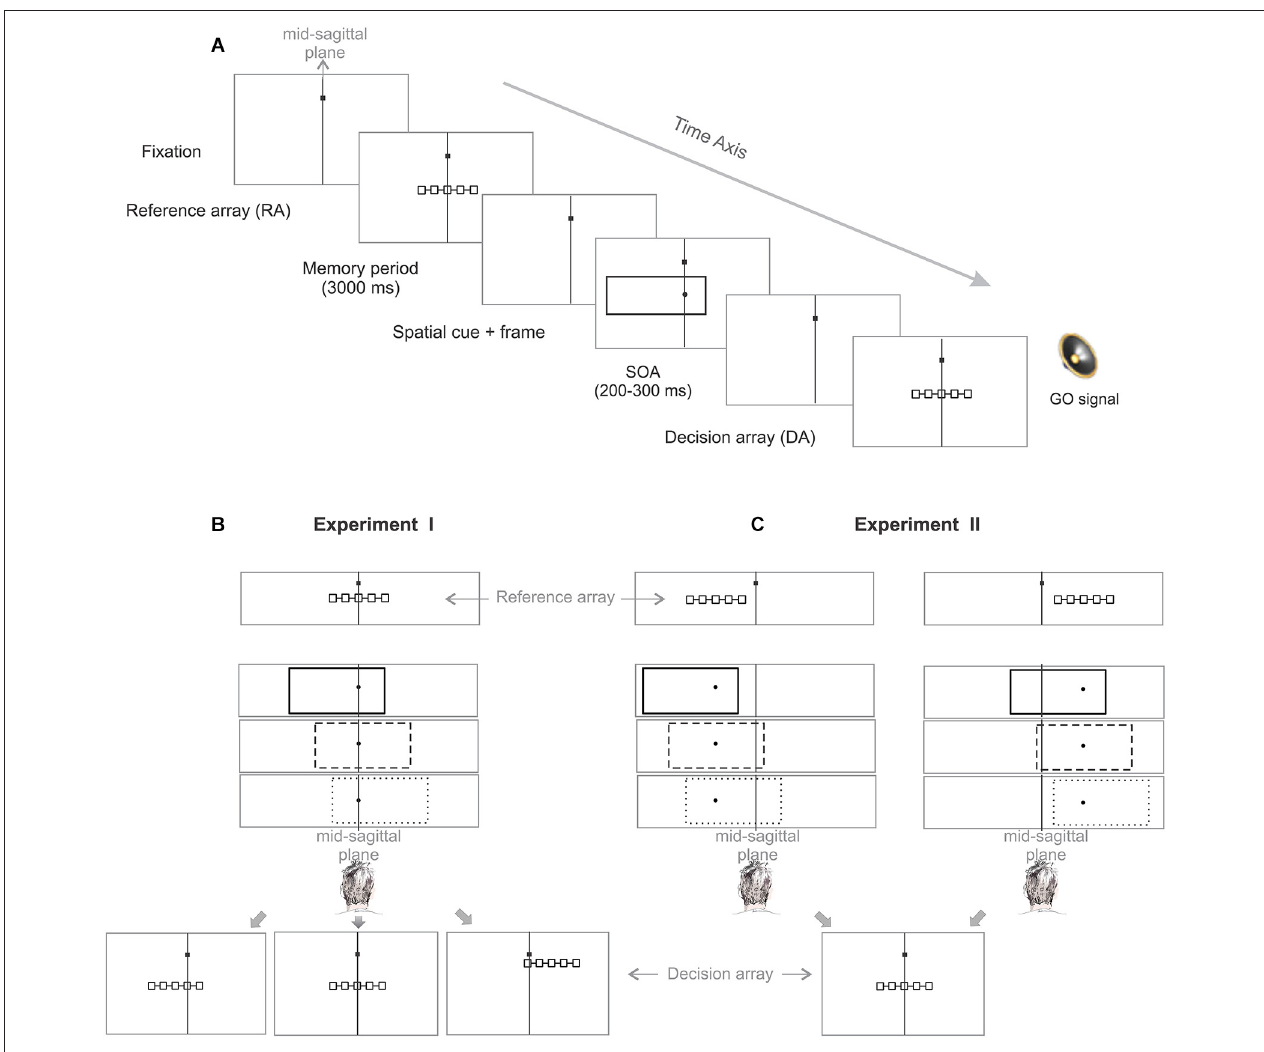
frame, we disentangled the position of the RA and DA for two-thirds of the trials. The congruency of the RA-DA was unpredictable to subjects in each trial. Therefore, to perform the task correctly, subjects had to encode the cue relative to the RA, i.e., use object-based (allocentric) spatial encoding. (C) Experiment II: In order to directly test the biased-midline hypothesis we disentangled the position of the RA from subject’s objective straight-ahead by randomly displaying the RA in either hemifield. The frame could take three different positions relative to the RA (allocentric shift of the frame to left, right or centered) for each RA location while it remained at the same side relative to the SSA (egocentric shift of the frame to the left/right for RA left/right